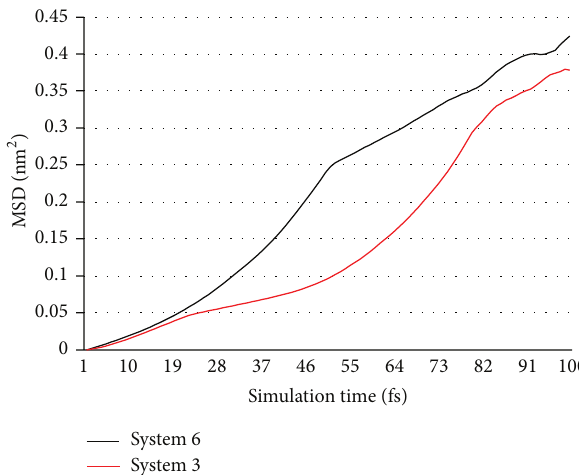
Figure 15: MSD curves of whole Fe atoms in systems 3 and 6.